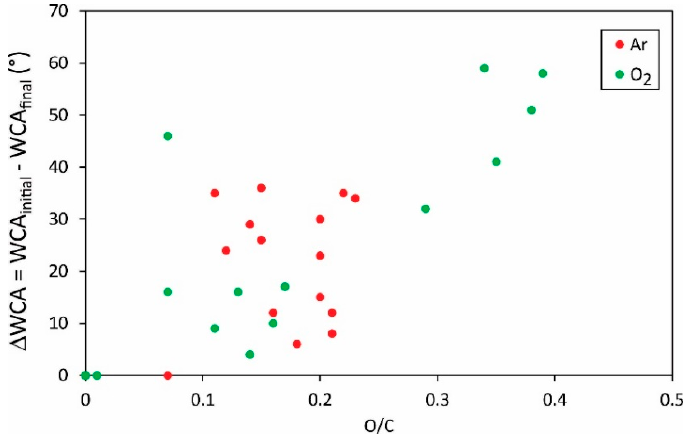
Figure 7. The change of the static water contact angle versus the O/C ratio in the surface film as probed by XPS.